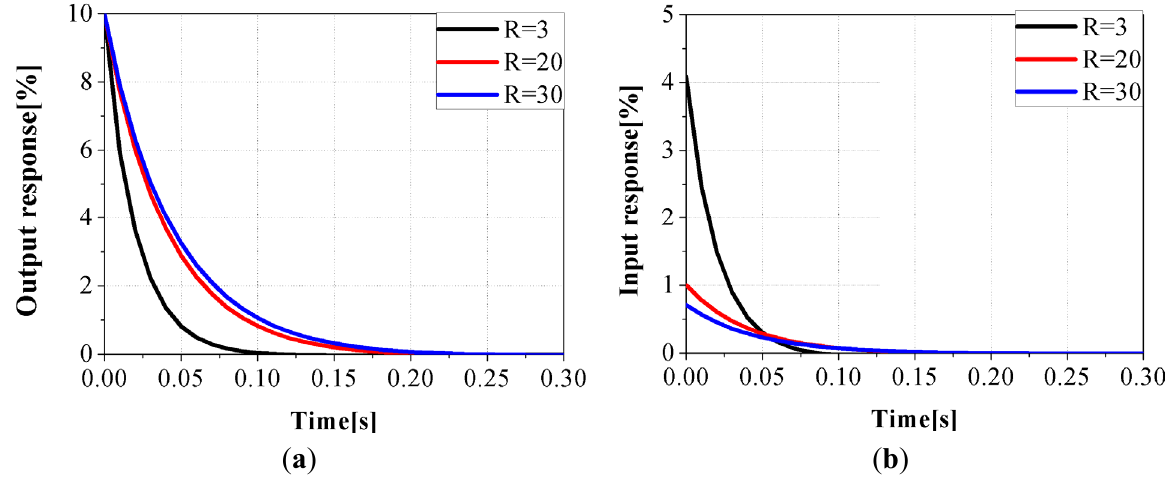
Figure 2. The optimal control results. ( a ) Output response; ( b ) Input